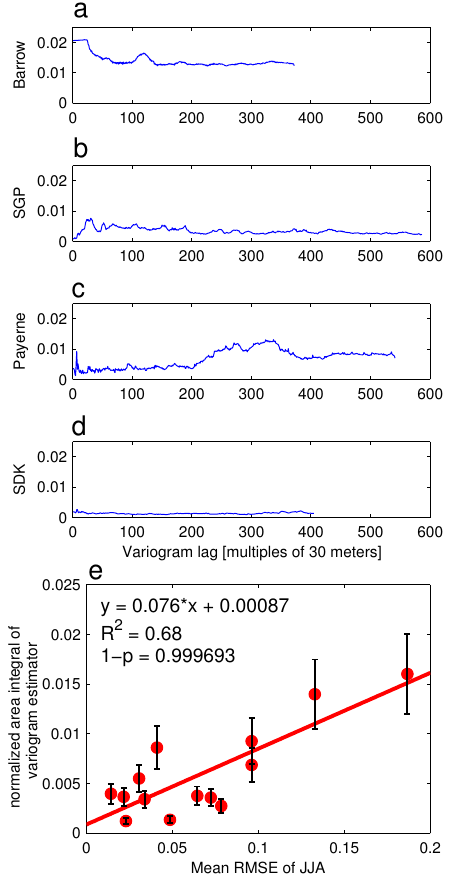
Fig. 8. Semivariogram estimators of Landsat channel 4 surface re- flectance for (a) Barrow, (b) Southern Great Plains, (c) Payerne, (d) Sodankyl¨a. (e) shows the correlation between the mean RMSE er- ror of the pentad CLARA-SAL products from the June-July-August period, and the normalized area integrals of the